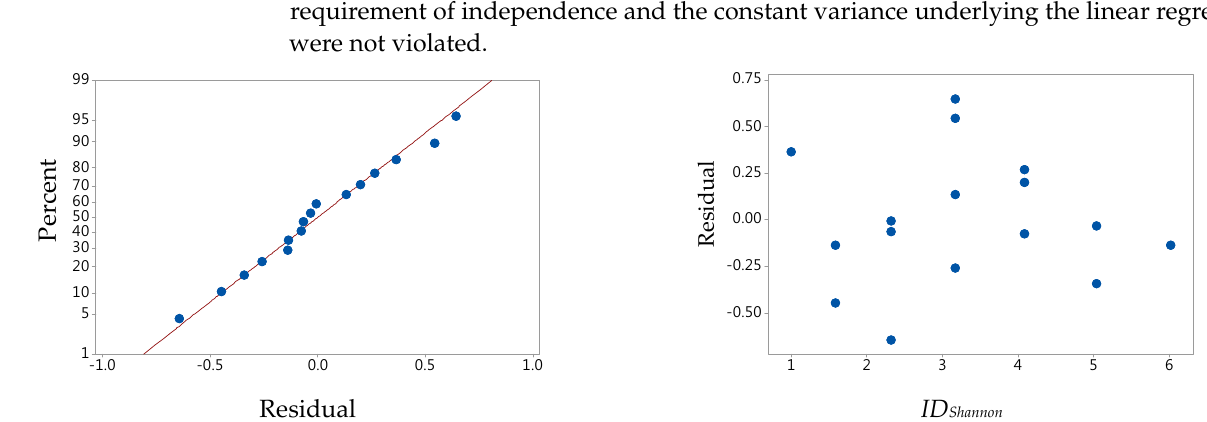
Figure 2. The normality plots of the residuals in the 1 oz stylus tapping task using the power model. The left side is residual vs. response percentage in the AD test; the right side is residual vs. (cid:3493)𝐴 𝑊⁄ . The residuals changed the plus/minus signs as compared with Figure 1, and the plot pattern indicated violation of the assumption of independence.